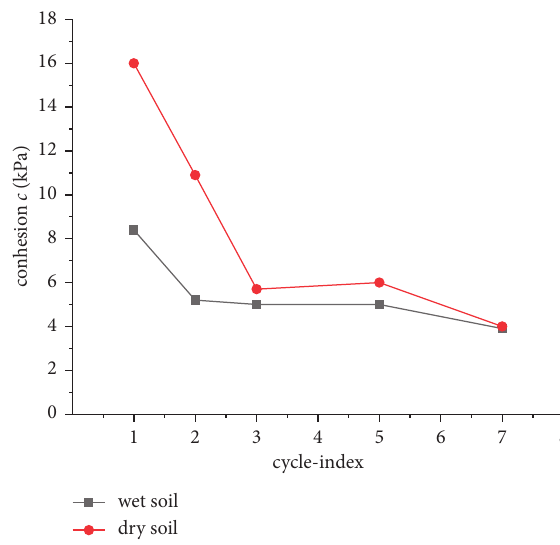
Figure 10: c -drying-wetting cycle curve.